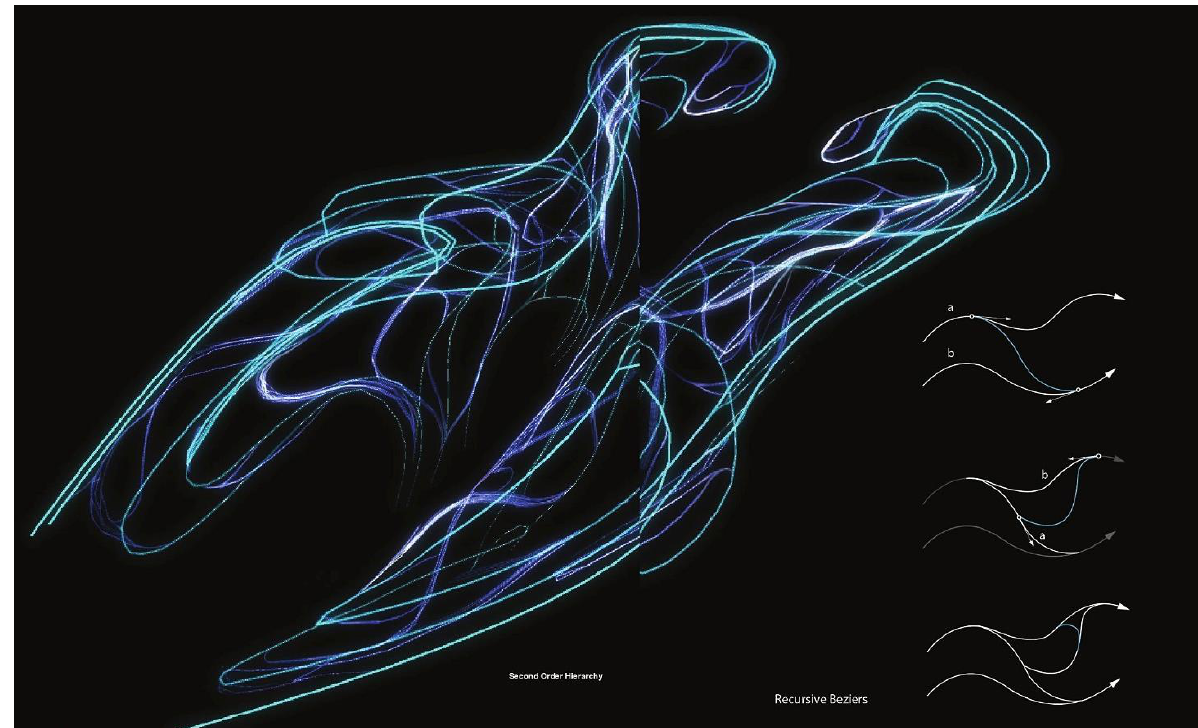
Figure 9. The branching behaviour will continuous recursively and finally generate a whole form of tine recursive curves of continuity and hierarchy. The behaviours are not isolated, they exchange in different situations and are